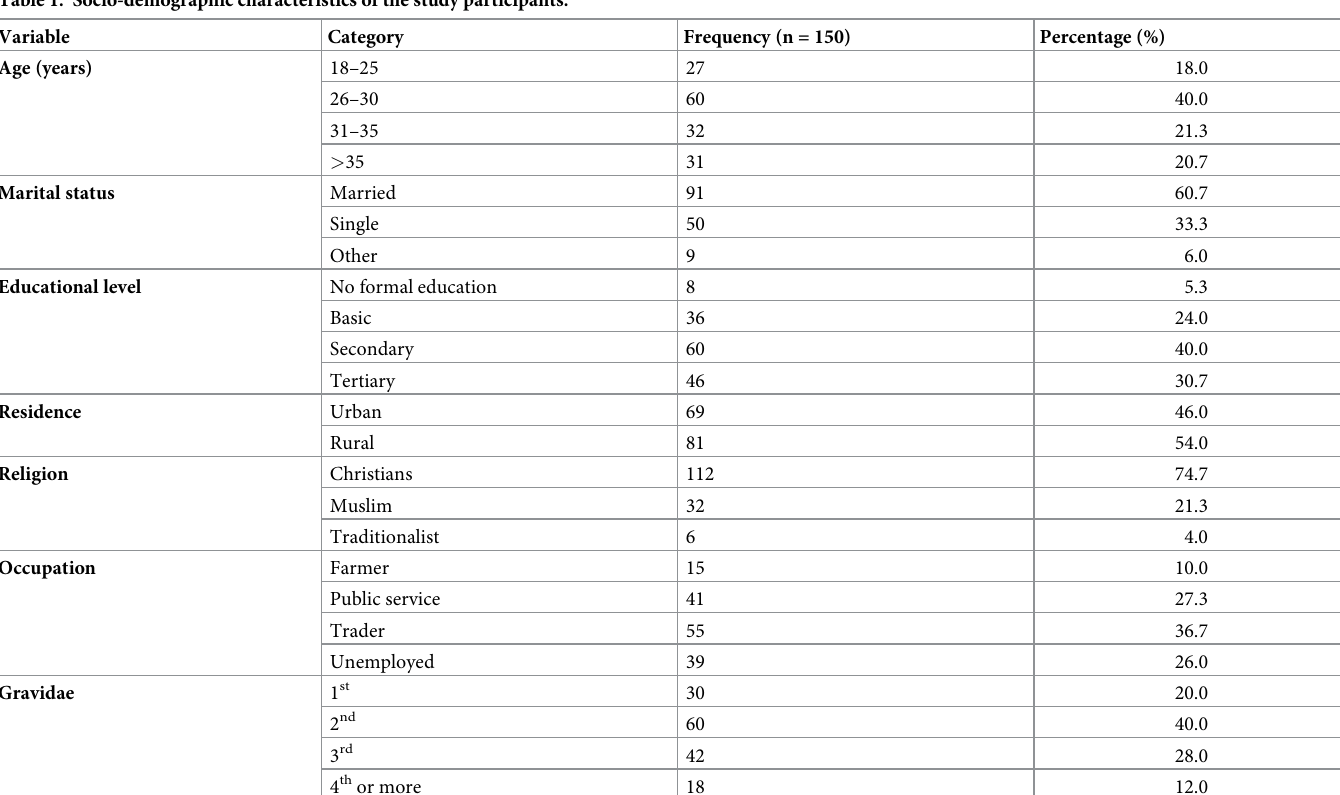
Table 1. Socio-demographic characteristics of the study